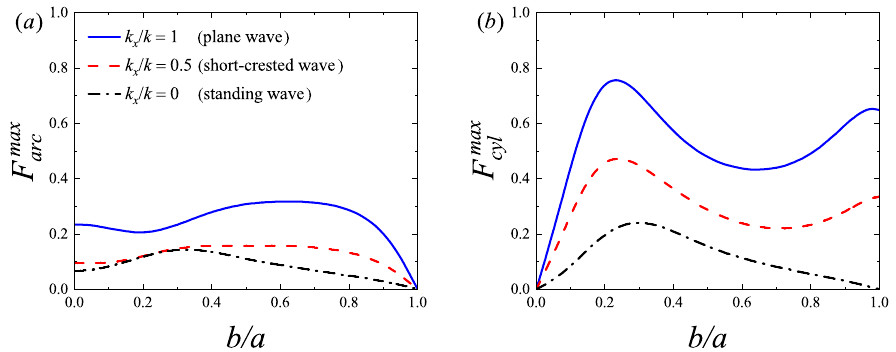
Figure 8. Variation in non-dimensional wave force on the two cylinders for different k x / k with ka = 4, h / a = 1, β = π /3, U 0 = 0.4 m/s, G = 1, α = 2 π /3, and γ = 2 π /3: ( a ) arc wall; ( b ) interior